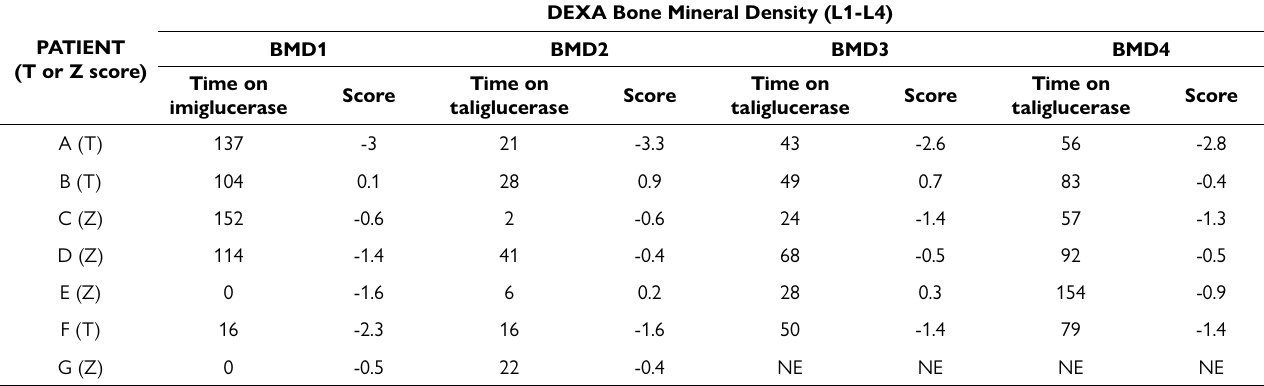
NE = not evaluated.